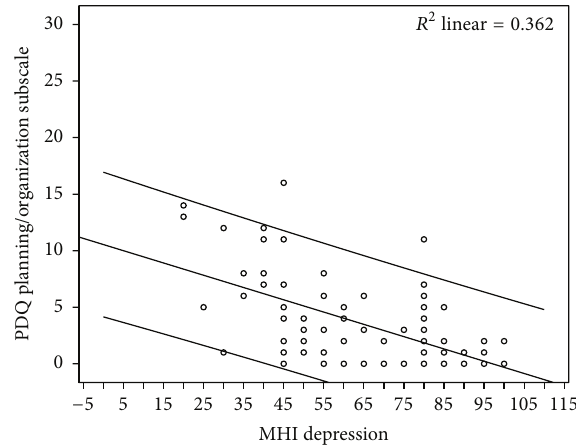
Figure 1: Scatter plot showing the relationship between depression and perceived impairment of planning/organization ability in pop- ulation of patients with